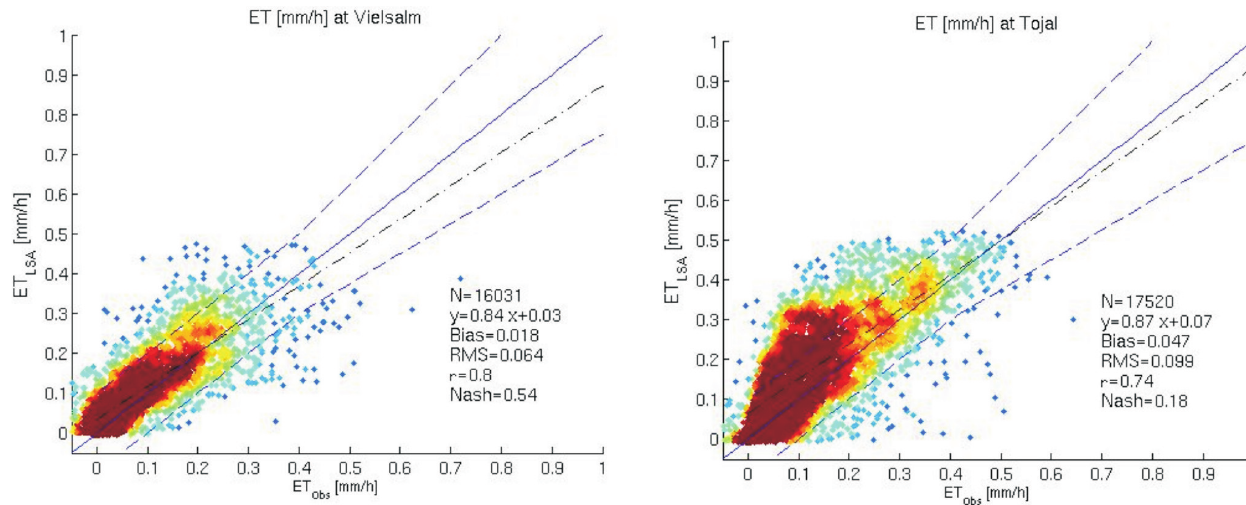
Fig. 3. Comparison between 30min LSA-SAF ET (mm h − 1 ) and observations at (left) Vielsalm FLUXNET station (Belgium) and (right) Tojal (Portugal). Period: March to November 2007. Dashed line: envelop associated to PRD criteria (see text); straight line: 1:1 line; Dashdoted line: linear regression line.